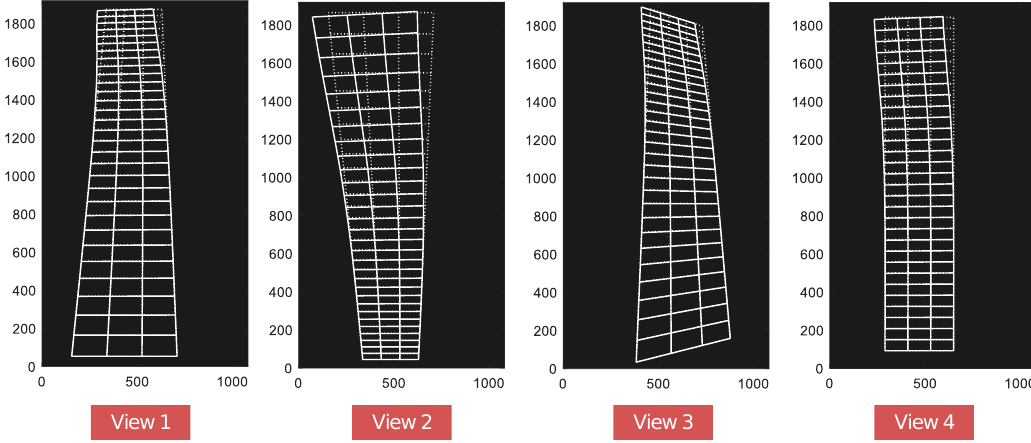
Figure 8. Synthetic views used in this example (building deformations are drawn to a scale of ten for enhanced